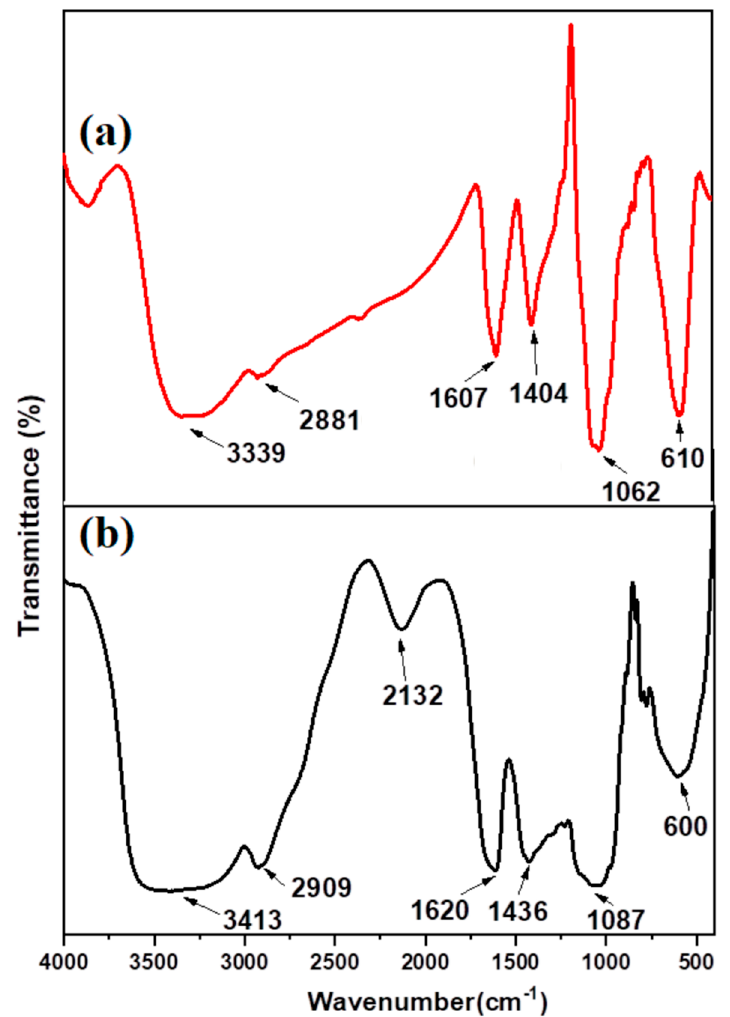
Figure 2. FTIR spectra of ( a ) GA and ( b ) GA-MNPs.